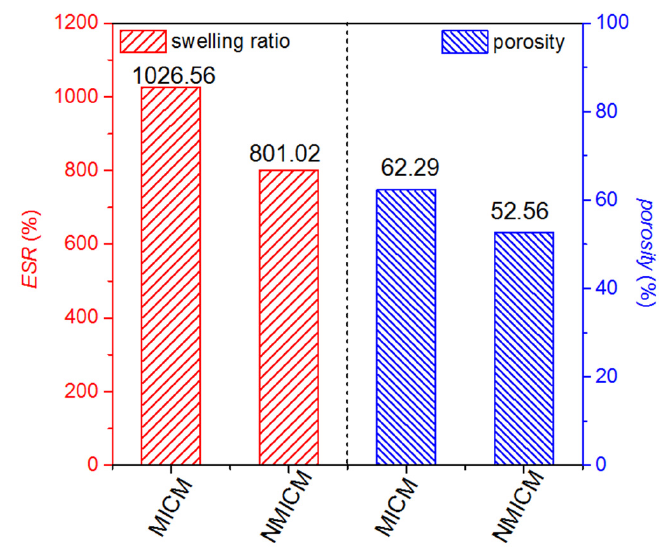
Figure 4. ESR and porosity of MICM and NMICM.